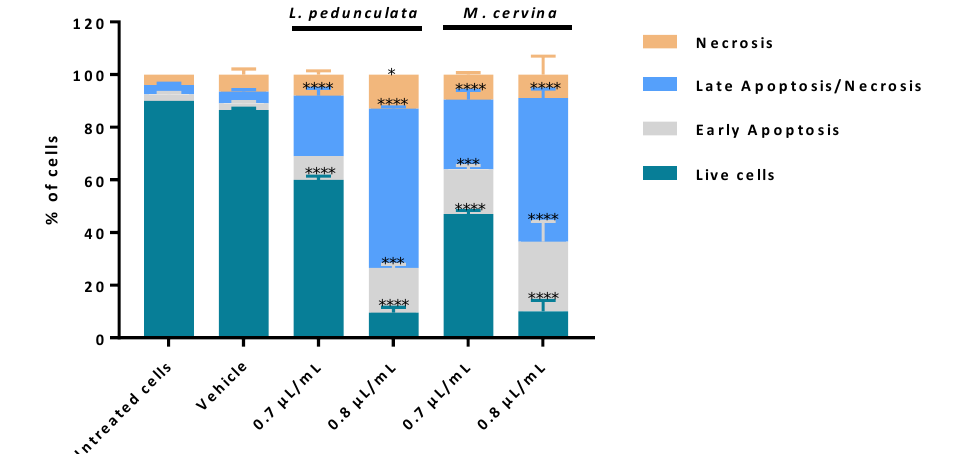
Figure 5. Assessment of cell death profile in U87 cell line by flow cytometry. Cells were treated either with L. pedunculata EO and M. cervina EO or with the vehicle control (DMSO), and further incubated for 24 h. After incubation, cells were co-stained with Annexin V and PI and the percentage of cells in apoptosis and non-apoptotic cells was determined. Asterisks (* p < 0.05, *** p < 0.001, and **** p < 0.0001) represent the values that significantly differ from the control (untreated cells). Data are expressed as mean ± SD.